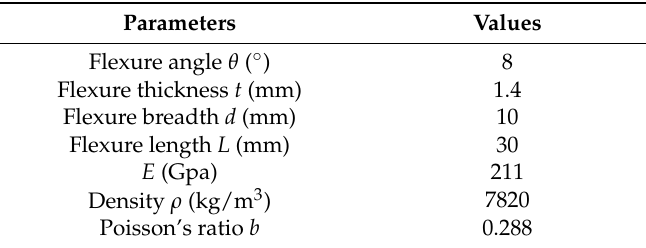
Table 2. Key geometric and material parameters of the diamond amplifier.